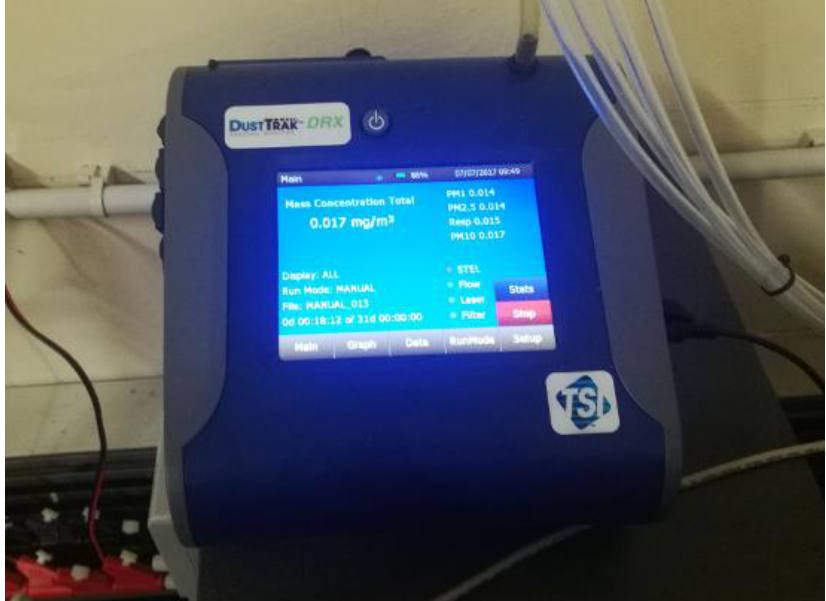
Figure 3. The TSI DustTrak DRX used for PM 2.5 and PM 10 laboratory calibration.